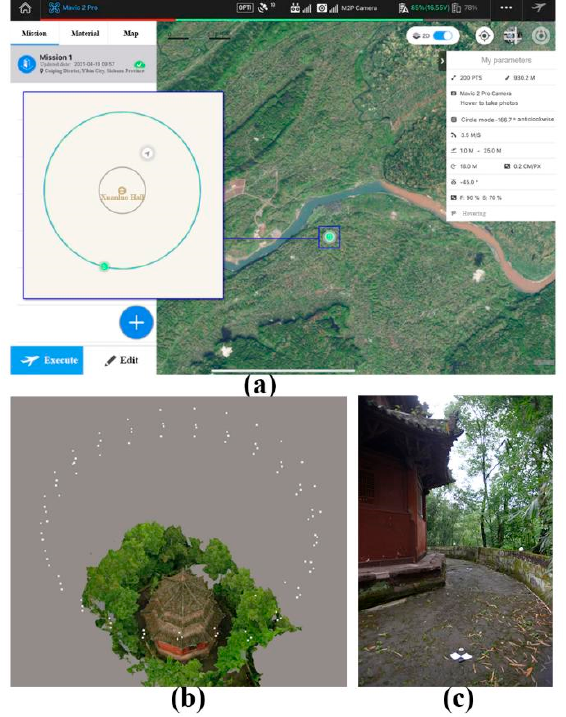
Figure 14. ( a ) Flight path arrangement with DJI GS pro; ( b ) Camera location; ( c ) Target of the control point.